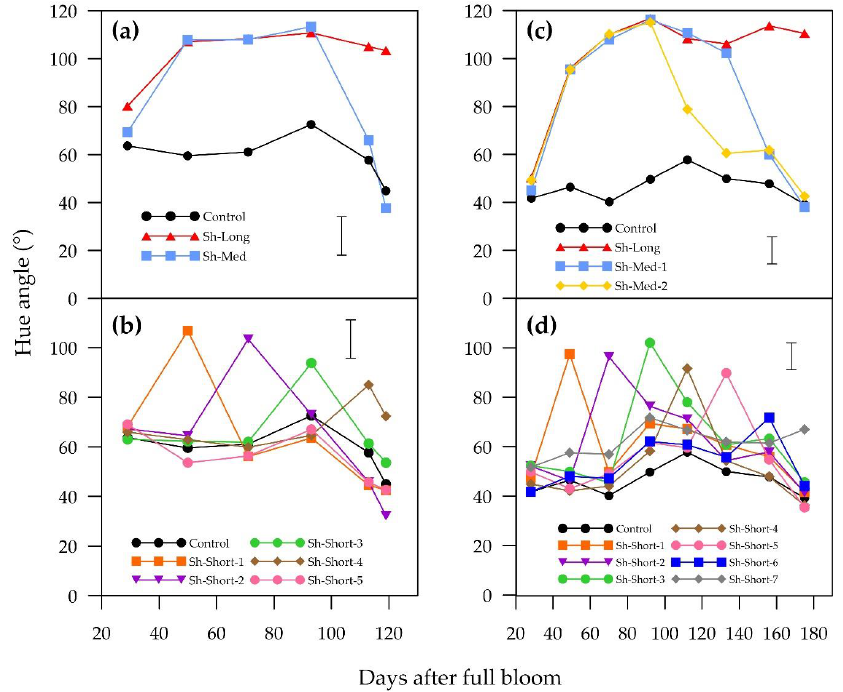
Figure 3. Temporal patterns of change in means of hue angle for “ANP-0118” ( a = long and medium shading treatments; b = short shading treatments) and “ANP-0131” ( c = long and medium shading treatments; d = short shading treatments). The control is displayed alongside treatments. Error bar represents Fisher’s LSD at 5% level of significance.